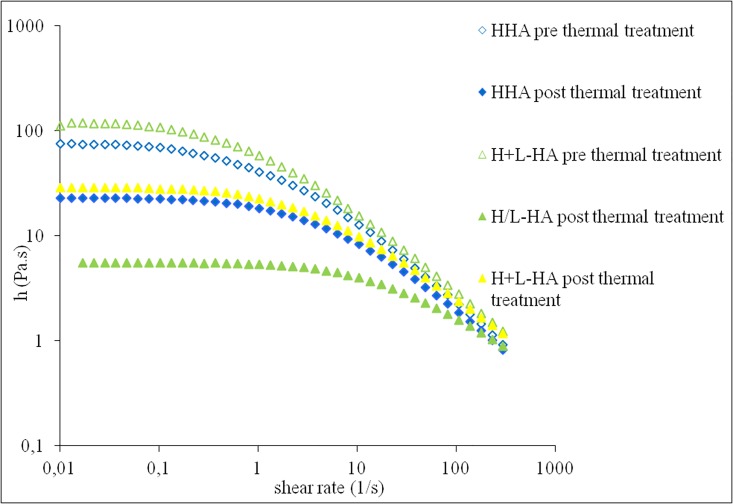
Flow curves (η vs shear rate) for H-HA pre and post thermal treatment (blue symbols void and solid, respectively), H+L-HA pre-thermal treatment (void green triangle), H/L-HA COMPLEXES hybrid cooperative complexes (green solid triangles), H+L-HA MIX: H-HA and L-HA separately thermally treated and then mixed after cooling (solid yellow symbols).